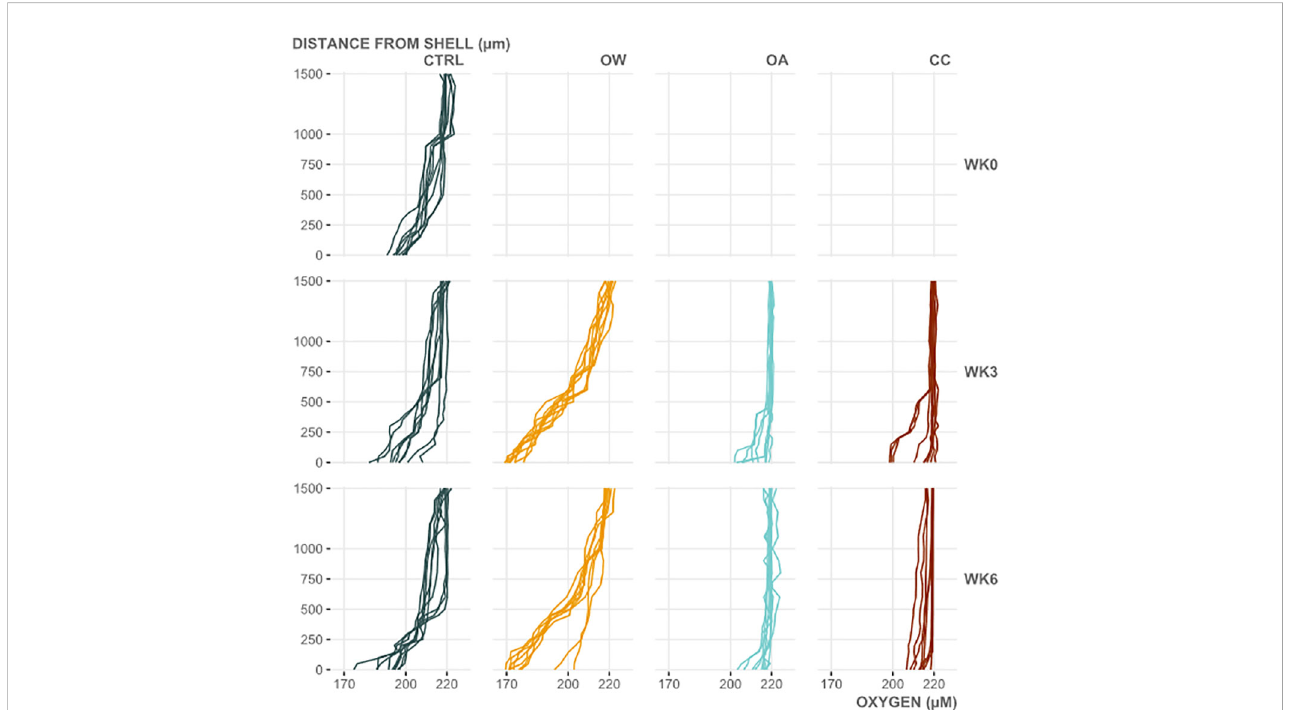
FIGURE 5 Vertical oxygen pro fi les of the microbial bio fi lm on Mytilus edulis shells, 1500µm above the shell surface, before seawater manipulations started (WK0) and after three and six weeks of manipulations (WK3 and WK6, respectively) in each experimental treatment [CTRL: control, OA: ocean acidi fi cation, OW: ocean warming and CC: climate change]. Pro fi les were measured on three random locations per replicate M. edulis shell (n=3) per timepoint and